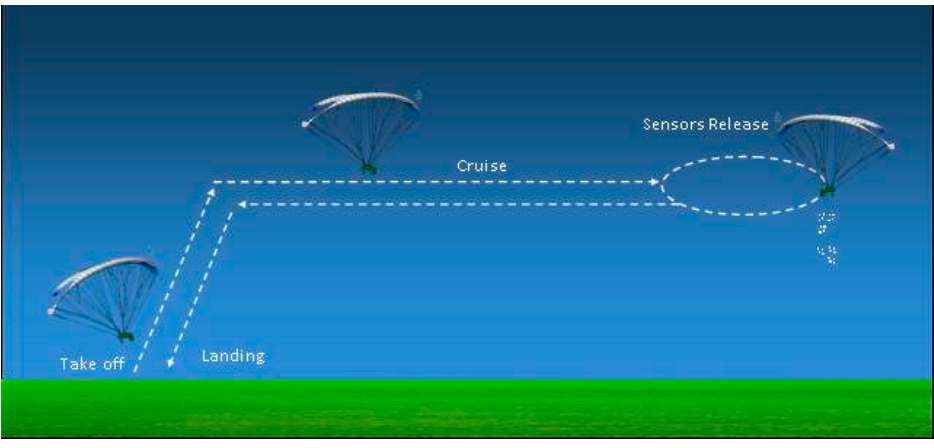
Figure 2. Typical mission of a UAS.